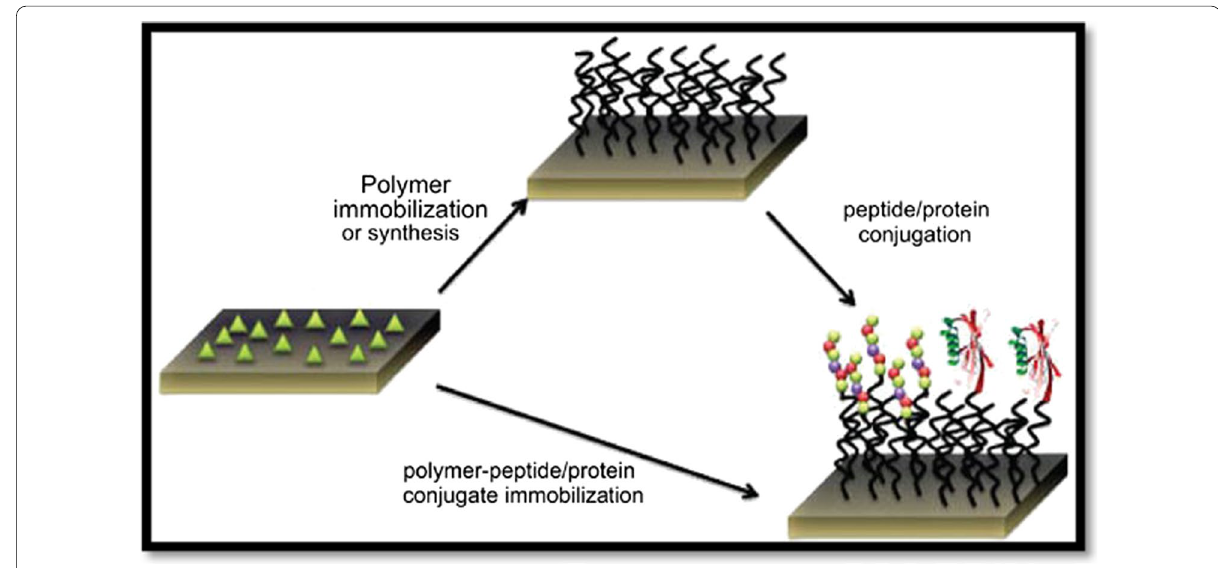
Fig. 7 Schematic representation of polymer protein conjugates [18]